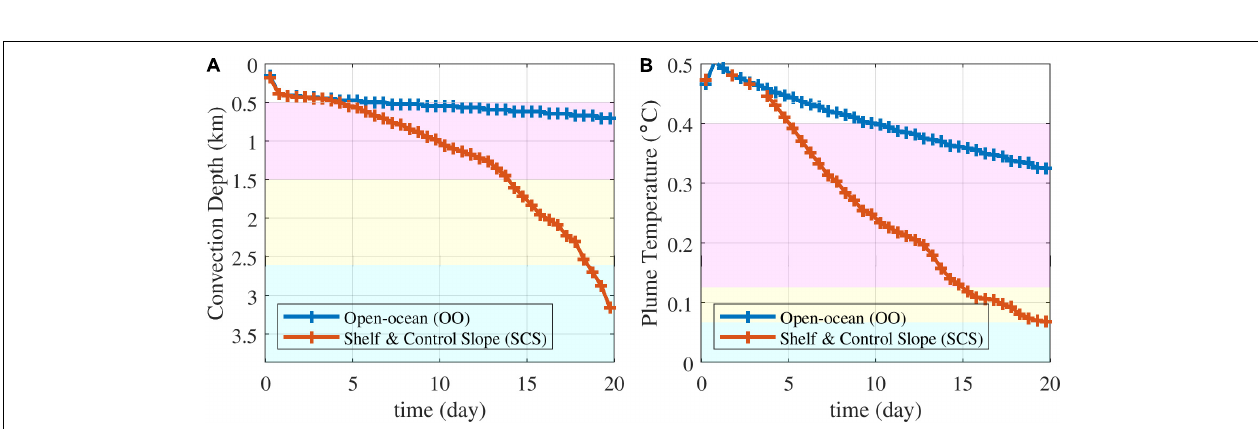
FIGURE 5 | (A) Depth and (B) potential temperature of the convective-plume head with time in the OO and SCS experiments. Background colors represent the range of water masses in the EJS based on Kim et al. (2004) (magenta: CW, yellow: DW, cyan: BW).